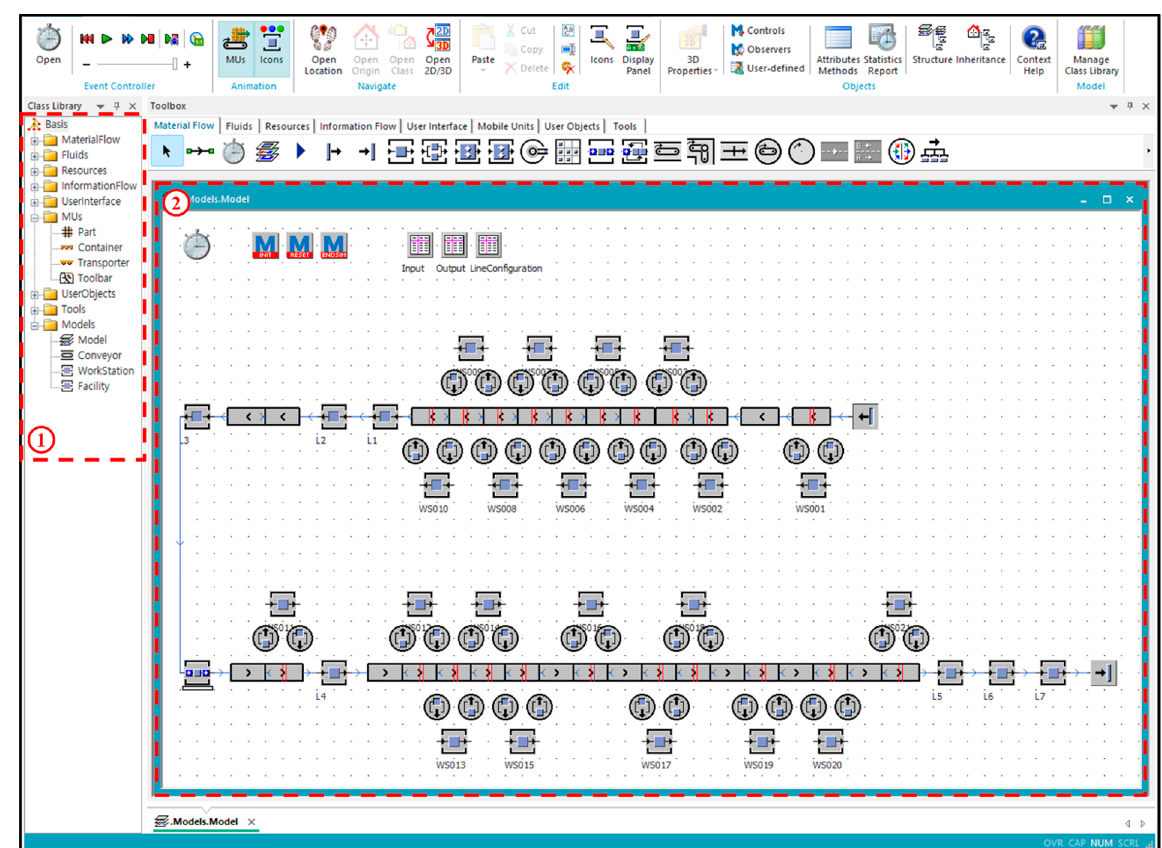
Figure 3. DT application implementation with the interface module.